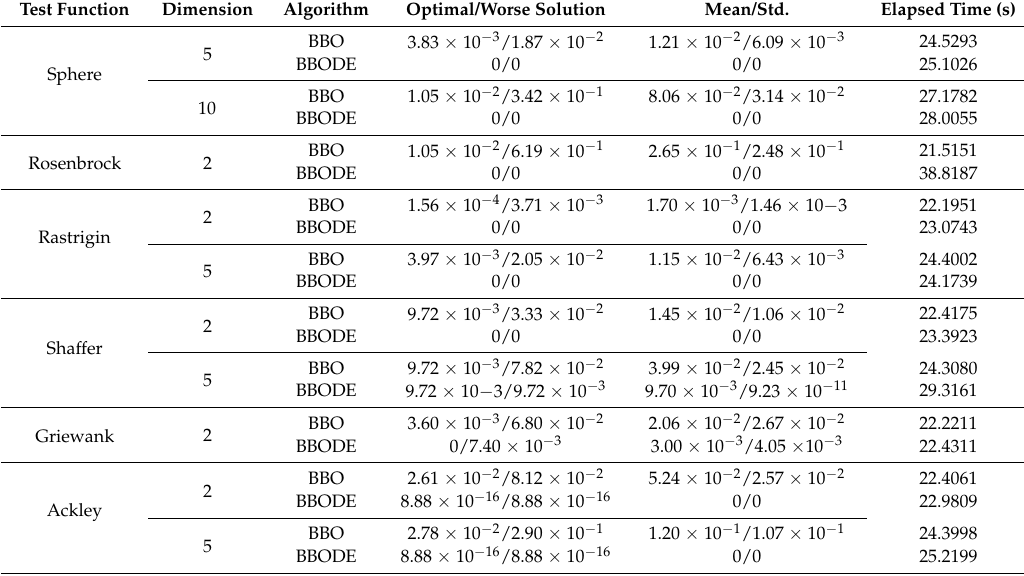
Table 4. Test results of BBO and